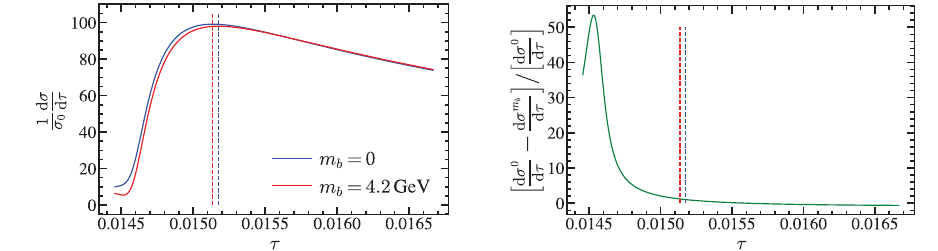
Figure 6: In this plot m b is the value of the bottom mass in GeV units and dashed lines mark the corresponding peak position.